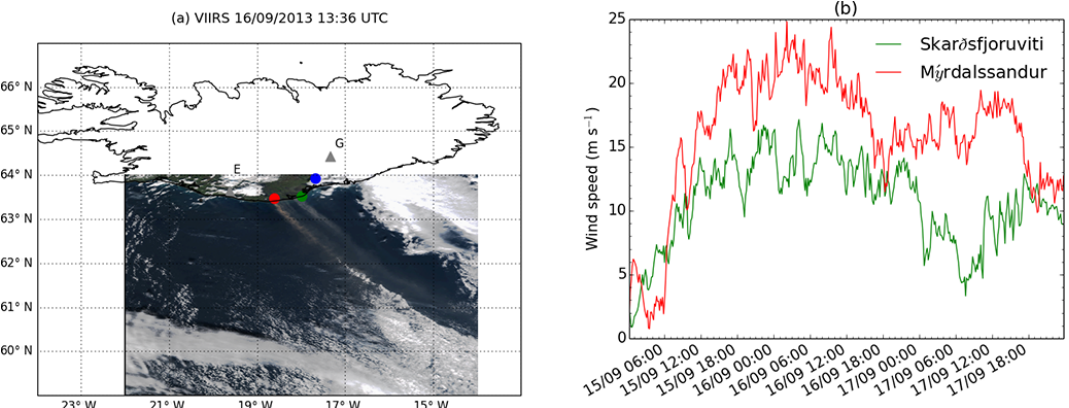
Figure 1. (a) “True”-colour VIIRS daytime image for 13:35UTC on 16 September 2013 with the locations of the Skarðsfjöruviti (green marker) and Mýrdalssandur (red marker) weather stations. The location of the OPC at Maríubakki is indicated by the blue marker. The locations of the volcanoes Eyjafjallajökull and Grímsvötn are indicated on the map by the E and G symbols respectively. (b) The recorded wind speeds at Skarðsfjöruviti and Mýrdalssandur during 15–17 September